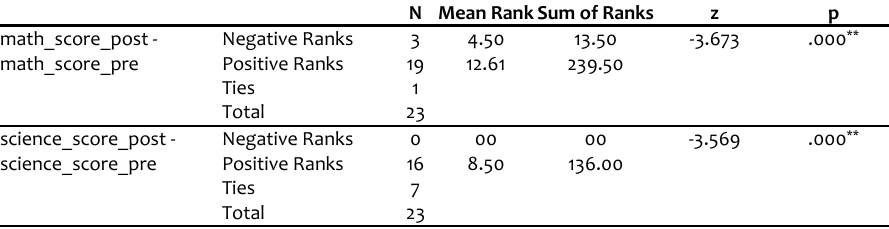
Table 5. Pre-test and post-test results of the practice scores in control